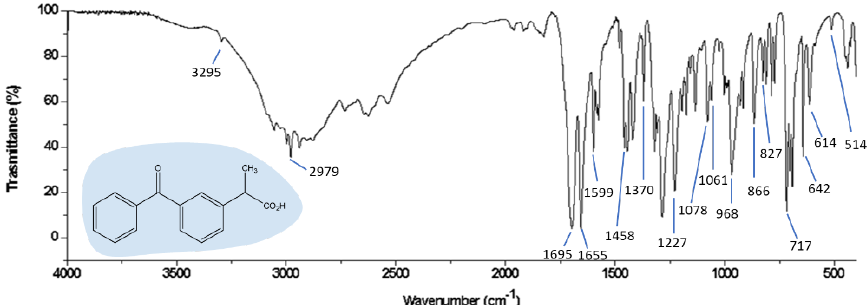
Figure 9. FT − IR spectrum of